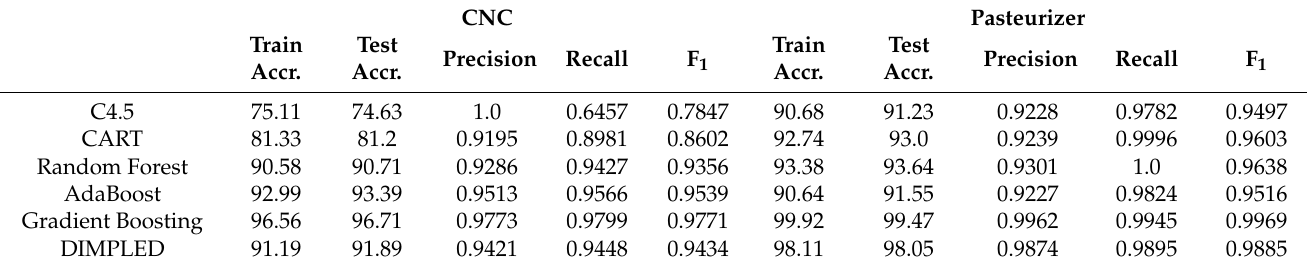
Table 7. Training and test performances of DIMPLED and tree-based algorithms for CNC and Pasteurizer datasets. CNC